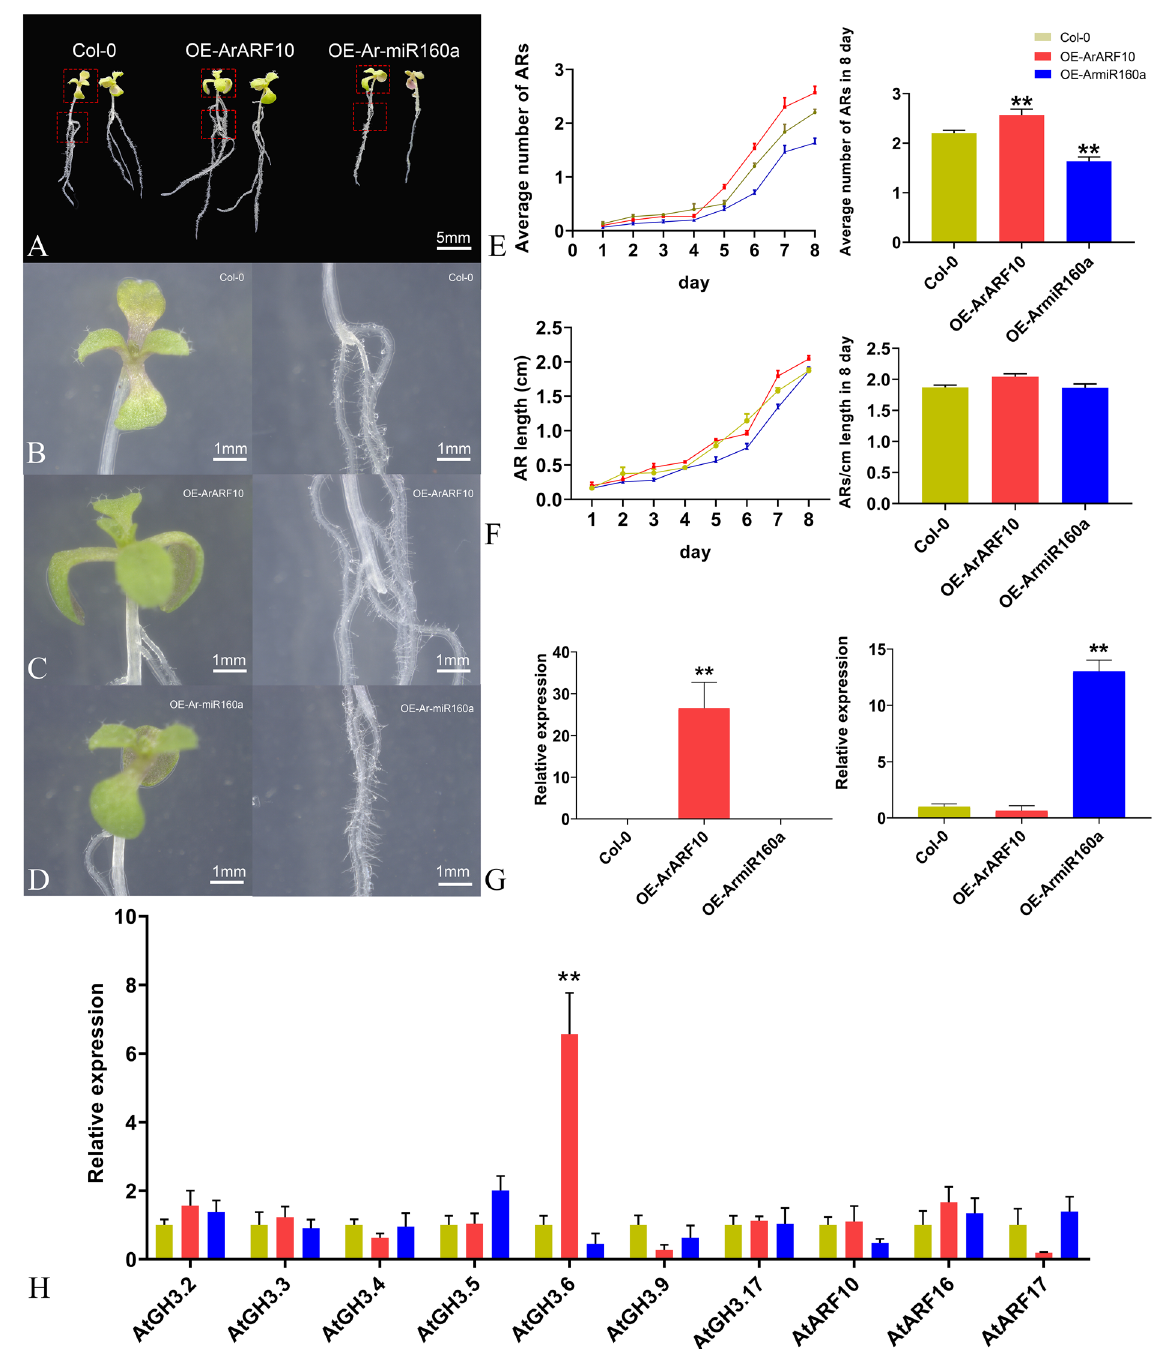
Figure 7. AR formation in transgenic A. thaliana overexpressing ArARF10 and Ar-miR160a . ( A ) Comparison of transgenic plants (OE- ArARF10 and OE- Ar-miR160a ) to Col-0 plants. Scale bar, 5 mm. ( B ) ARs of WT phenotypes incubated under long-daylight conditions for 8 days. ( C ) Overexpression of ArARF10 promoted AR formation. ( D ) Overexpression of Ar-miR160a inhibited AR formation. Scale bar, 1 mm. ( E ) Left panel shows changes in the number of ARs in Col-0, OE- ArARF10 and OE- Ar-miR160a lines over 8 days. Right panel showed the number recorded on day 8, showing a significant increase in OE- ArARF10 ARs and a significant decrease in OE- Ar-miR160a ARs compared to the WT. Error bars show SEM (**p < 0.01, n = 3). ( F ) Left panel shows the changes in AR length in Col-0, OE- ArARF10 and OE- Ar-miR160a lines over eight days. Right panel shows the AR length recorded on day 8, with few changes in OE- ArARF10 and OE- Ar-miR160a AR lengths compared to the WT. ( G ) The relative expression levels of ArARF10 in OE- ArARF10 (left panel) and Ar - miR160a in OE- Ar-miR160a (right panel). ( H ) Expression patterns of endogenous genes in transgenic and Col-0 plants. Error bars show SEM (**p < 0.01, n =